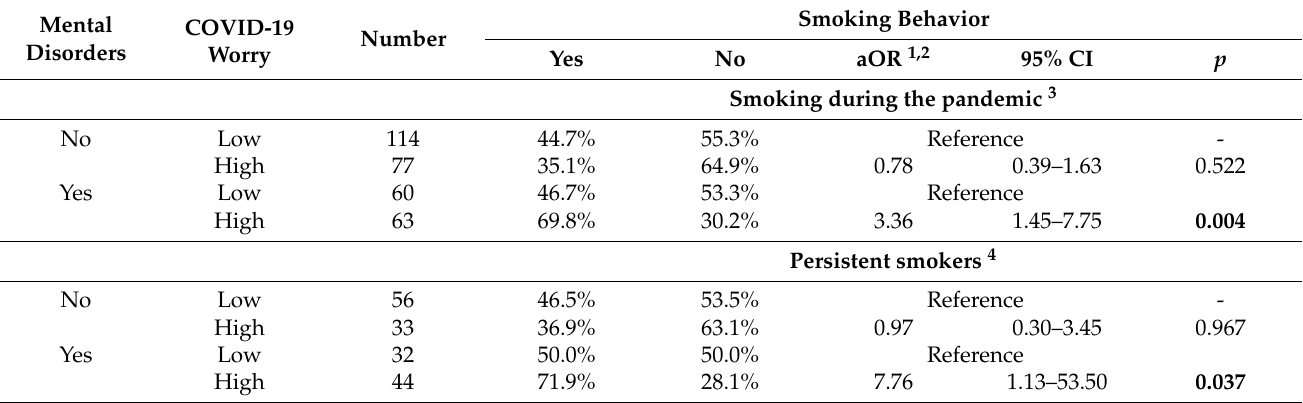
Table 4. Effect of COVID-19-related worry scores, as a measure of stress, on smoking status during the COVID-19 pandemic stratified by the presence of a mental disorder.